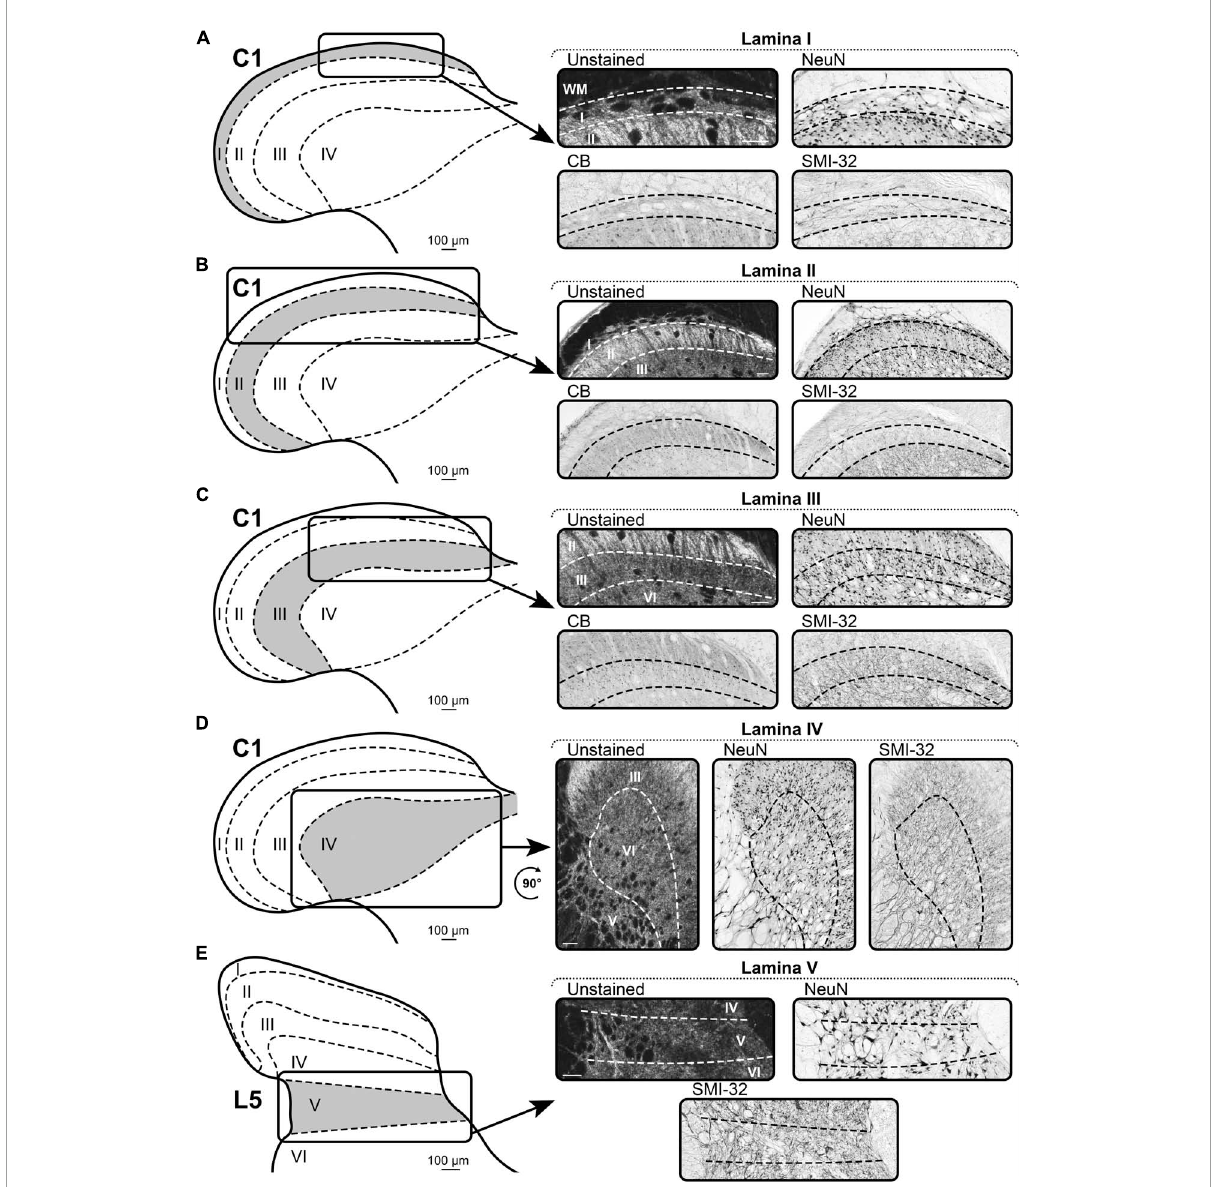
FIGURE4 A representative example of the markers of Rexed’s laminae I–V of spinal cord. (A–D) Spinal segment C1. (E) Spinal segment L5. (A) Laminae I. (B) Laminae II. (C) Laminae III. (D) Laminae IV. (E) Laminae V. Scale bar is 100 µ m.